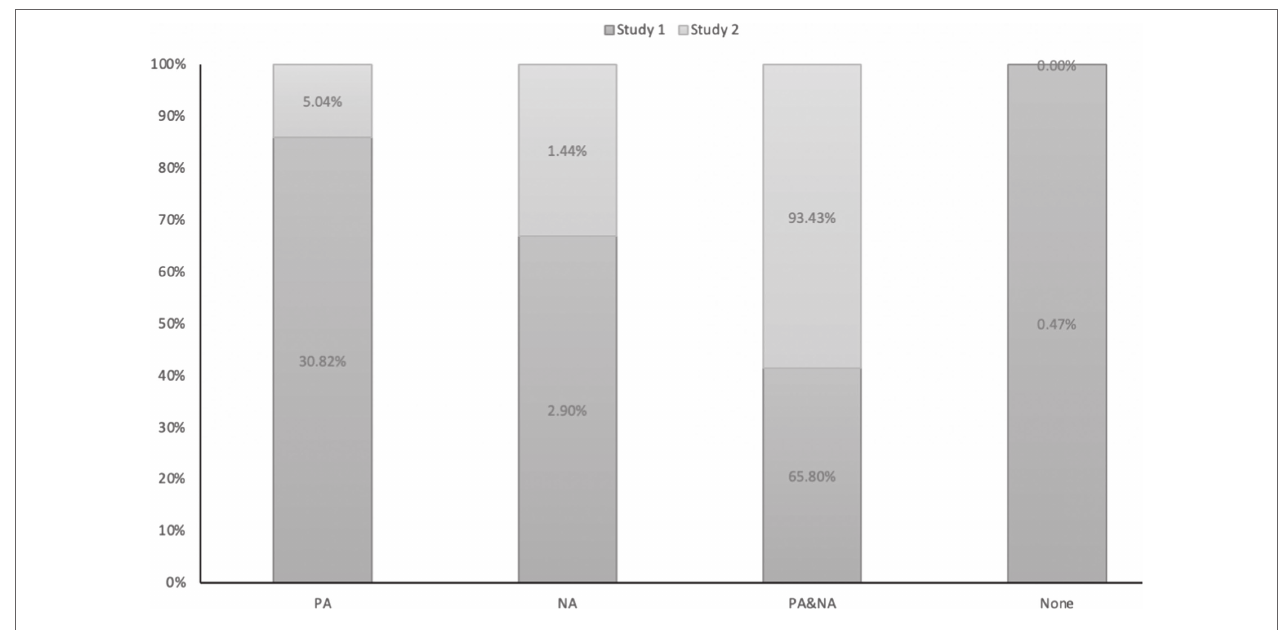
FIGURE 1 | Frequency of positive affect and negative affect in Studies 1 and